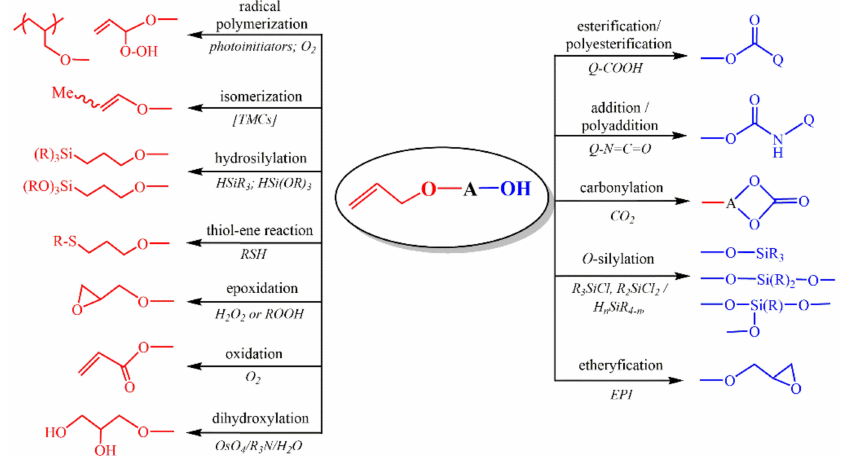
Scheme 1. Selected industrially important one-step transformations of